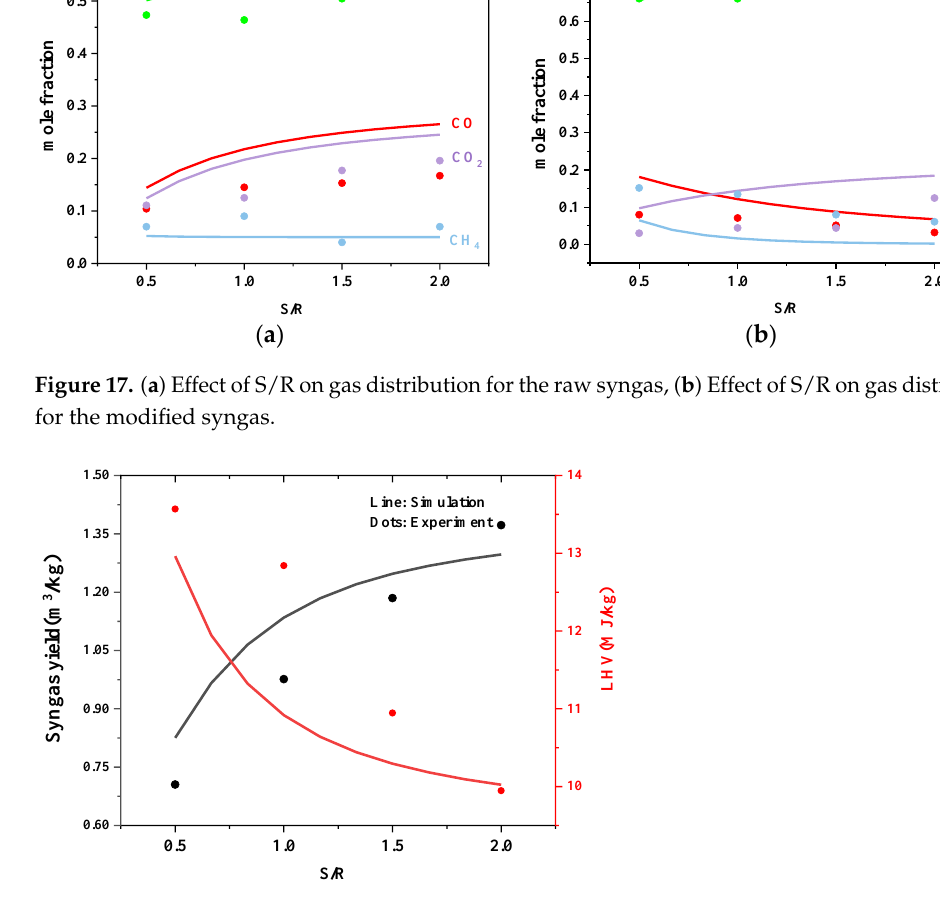
Figure 18. Effect of S/R on syngas yield and LHV for the modified syngas.